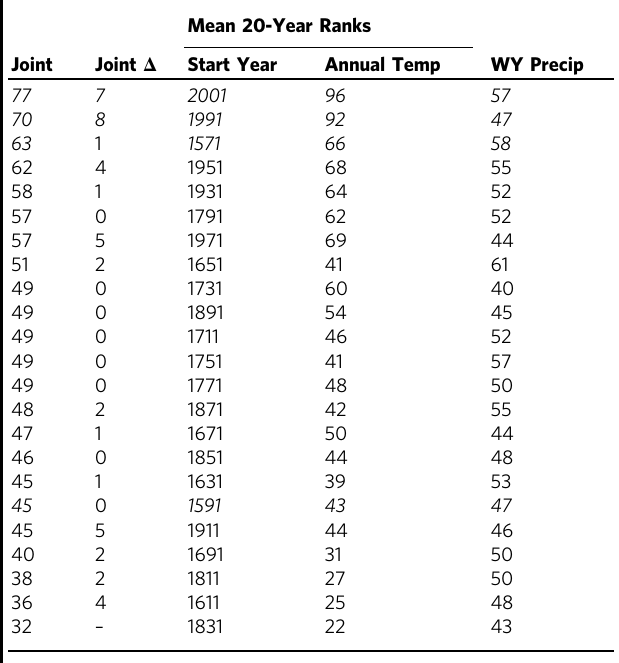
Table 1 Running bidecadal period rankings for SW historical precipitation and